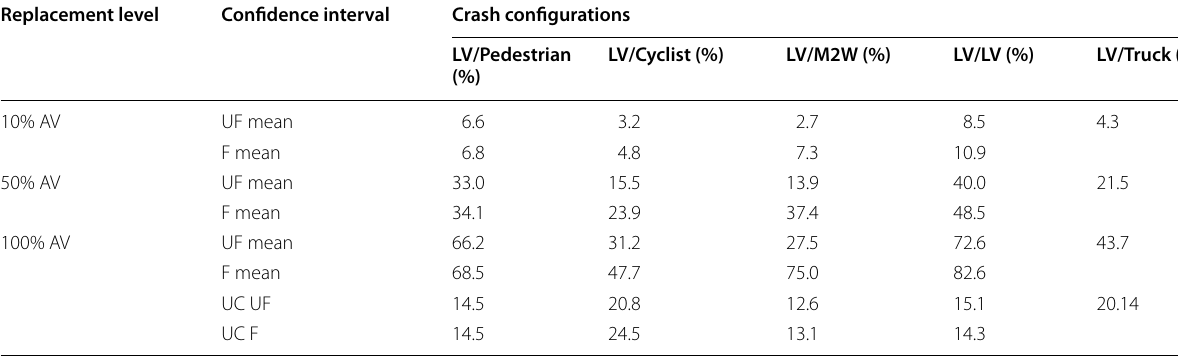
AV, Autonomous Vehicle; LV, Light Vehicle; M2W, Motorized-Two-Wheeler; UF, Unfavourable; F, Favourable; UC, Uncovered * % on 100% injury crashes within each configuration